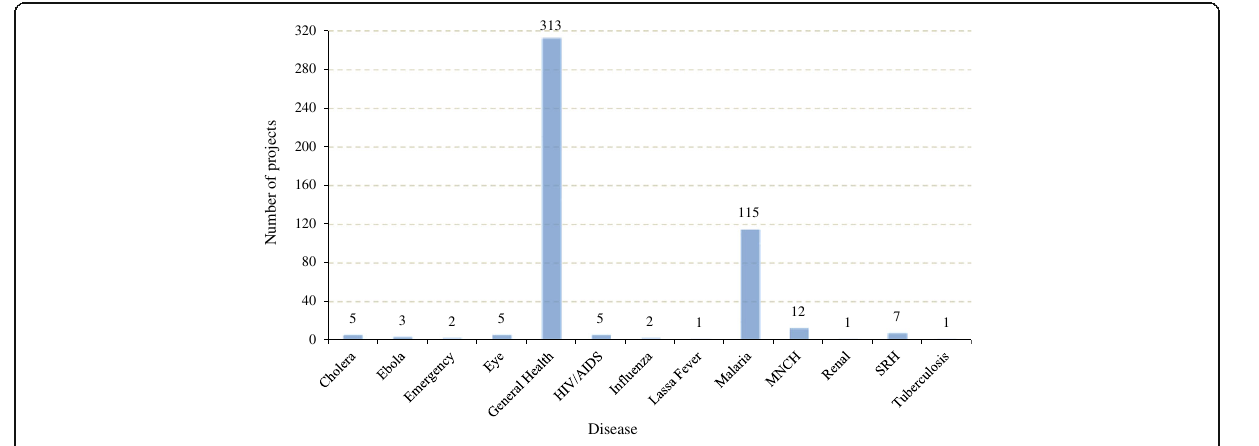
Fig. 3 Number of projects by disease (WASH not included)